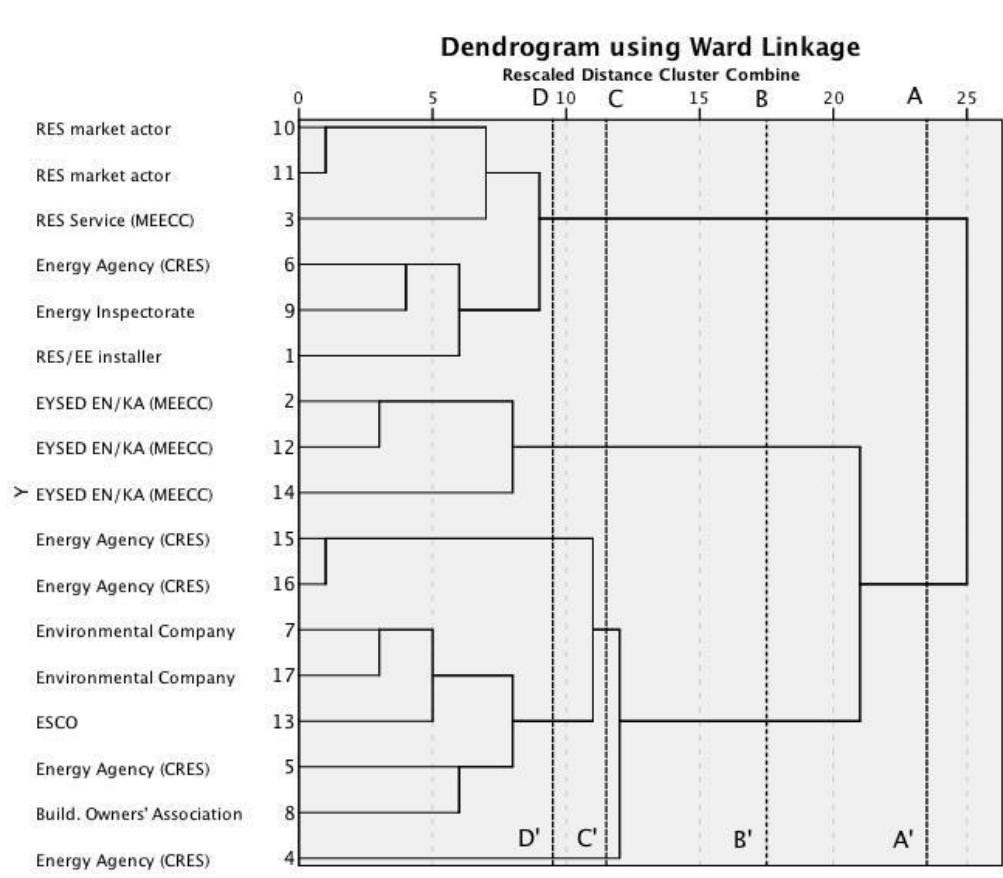
Figure 2. Dendogram of clusters according to group weights. Group composition as delineated by the cutting line B-B’: Group 1: RES market actors, RES service (MEECC), Energy Efficiency Division (CRES), Energy Inspectorate (MEECC) RES/EE installers, Group 2: Representatives from the EYSED